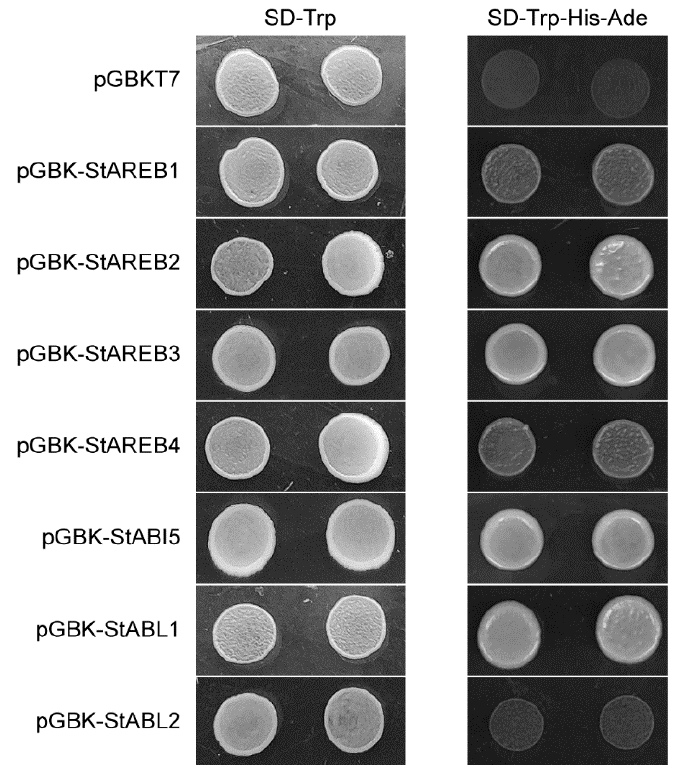
Figure 4. Transcriptional activation analysis of potato AREB/ABF/ABI5 members in yeast. The recombinant vectors were transferred into yeast strain AH109. The transcriptional activation ability of these proteins was analyzed by growing on SD/-Trp and SD/-Trp-His-Ade plates. The yeast strain AH109 harboring the pGBKT7 vector was used as a negative control.